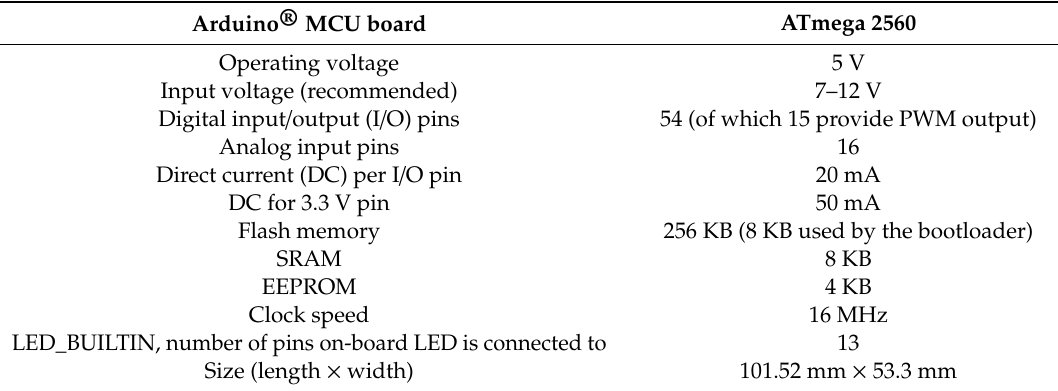
Table 1. Technical specifications of Arduino MEGA 2560 micro-controller unit (MCU) [21,23,39]. SRAM, static random access memory; EEPROM, electrically erasable programmable read-only memory; PWM, pulse width